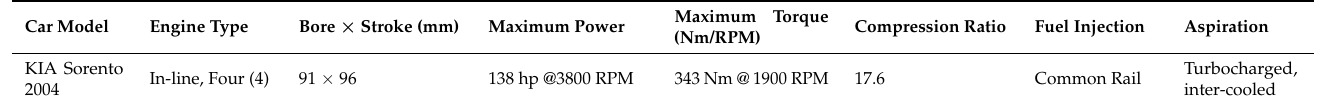
Figure 2. A view of ( a ) actual experiment setup; ( b ) schematic view of experimental setup. Table 1. Test engine